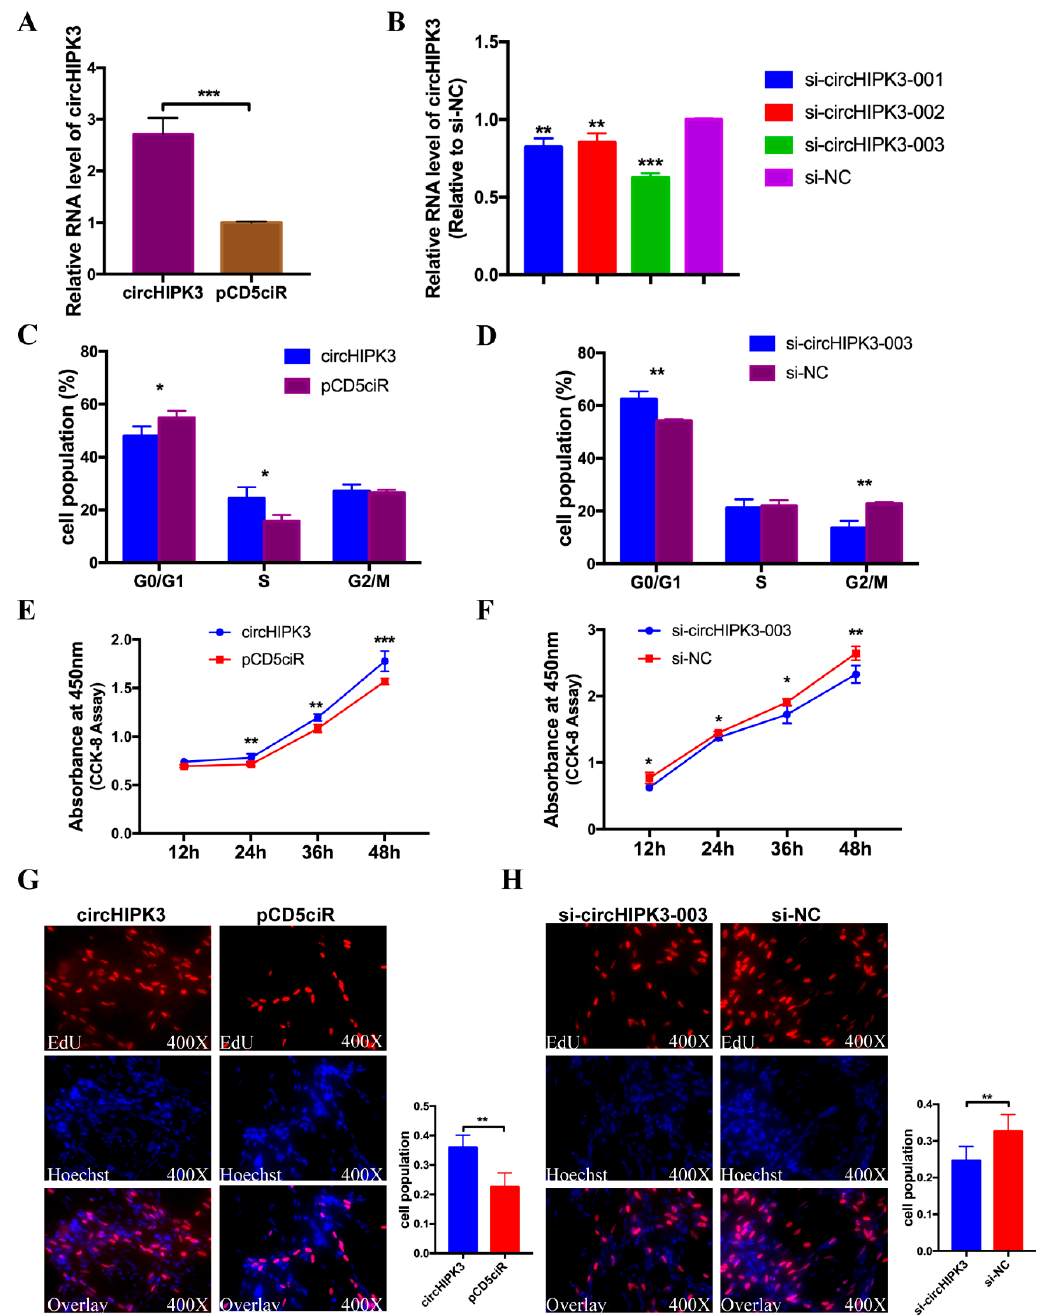
Figure 6. circHIPK3 promotes the proliferation of CPMs. ( A ) The over-expression effect of circHIPK3 over-expression vector in CPMs. ( B ) The interference effects of three siRNAs of circHIPK3 in CPMs. ( C , D ) Effect of circHIPK3 on cell-cycle progression of CPMs. The plot of cell-cycle analysis in different cell-cycle phases was compared. ( E , F ) The growth curves of CPMs were measured after the transfection of over-expression vector and siRNA of circHIPK3. ( G , H ) EdU assays for CPMs with over-expression and inhibition of circHIPK3. In all panels, the values represent mean ± SEM from three independent experiments. * p < 0.05; ** p < 0.01; *** p < 0.001.